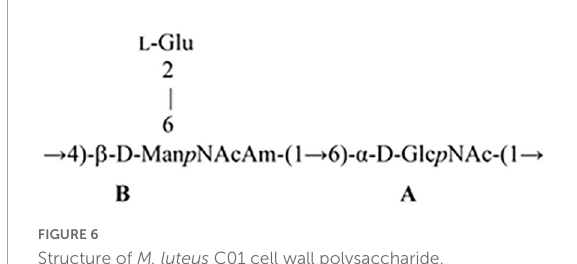
FIGURE6 Structure of M. luteus C01 cell wall